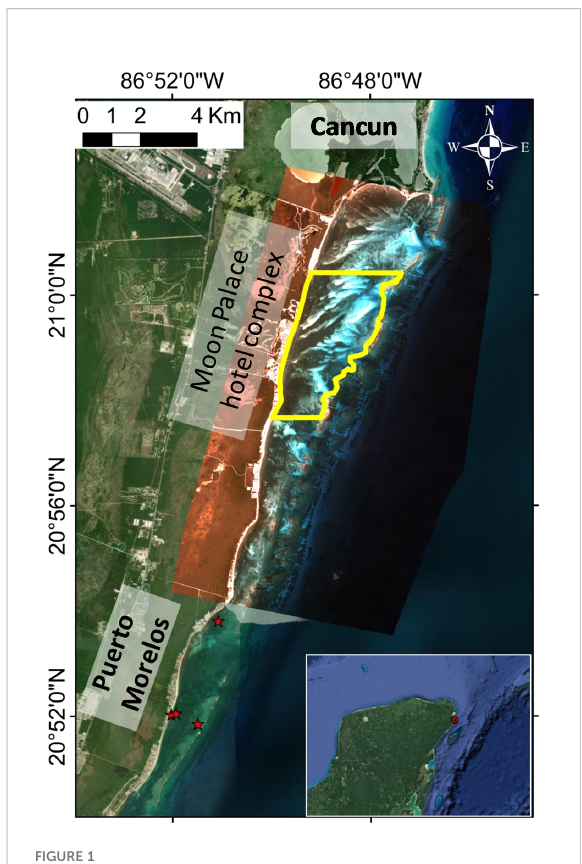
FIGURE 1 Study area (yellow outline) and long-term seagrass monitoring stations (red stars, acquired during the Caribbean Coral Reef Productivity Program (CARICOMP), from 1993 to